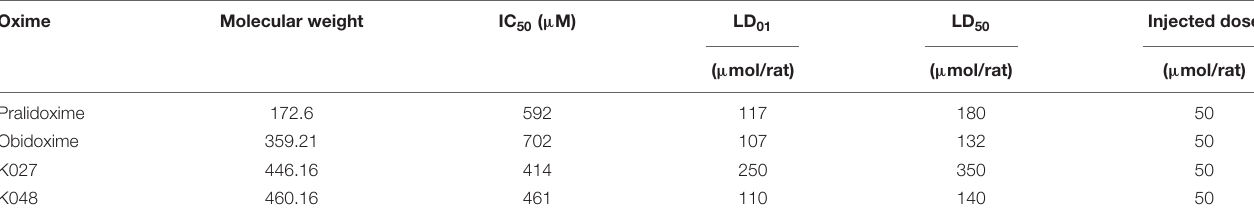
TABLE 2 | Chemical and biological parameters of the experimental (K027, K048) and established (pralidoxime, obidoxime) oxime reactivators of organophosphate- inhibited acetylcholinesterase (AChE). Oxime Molecular